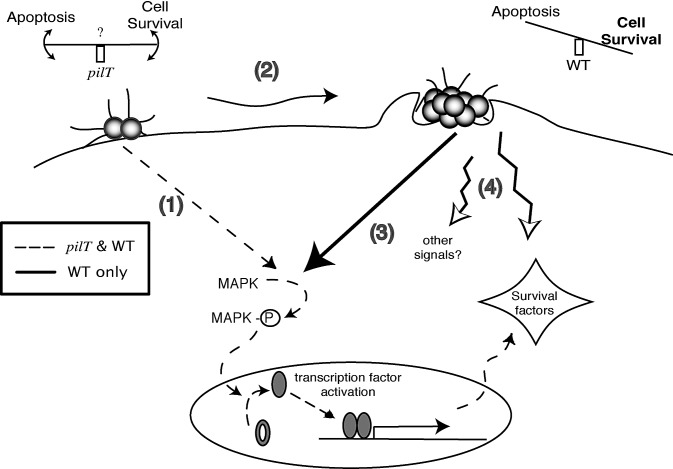
Model of the Role of Pilus Retraction in Promoting a Cytoprotective Environment during Gonococcal Infection of an Epithelial Cell(1) Initial contact between the bacterium and host cell activates low levels of MAPK, and transcription of infection-induced genes. This level of signaling may or may not be able to protect the cell from apoptosis; thus, the host cell “teeters” on the edge of life and death.(2) As the infection proceeds, microcolonies of gonococci are formed, and more pili are locally available to retract.(3) Pilus retraction amplifies MAPK activation, which in turn enhances the transcription of mechanical stress–induced genes.(4) Pilus retraction may also stimulate other pathways that mediate gene expression and survival signaling. Overall signaling events tip the balance in favor of cell survival.